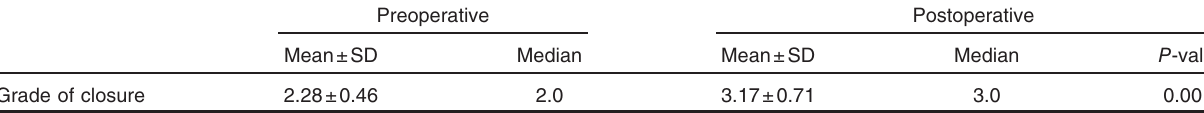
Table 2 Difference in the grade of closure preoperatively and postoperatively